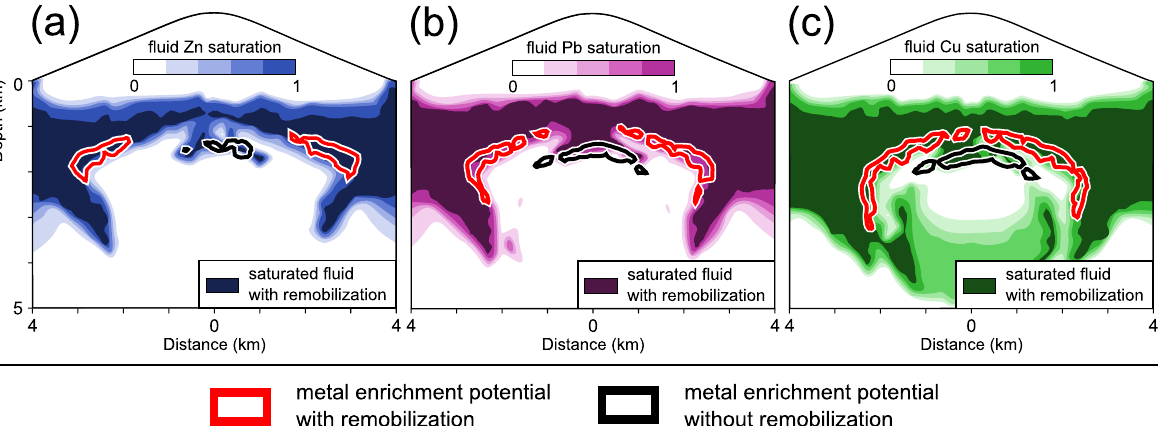
Figure 6. Location of Cu ( a ), Zn ( b ) and Pb ( c ) enrichment potentials of 500 after 25 kyrs of simulation time with (red isoline; simulation 4) and without (black isoline; simulation 2) metal remobilization, as well as